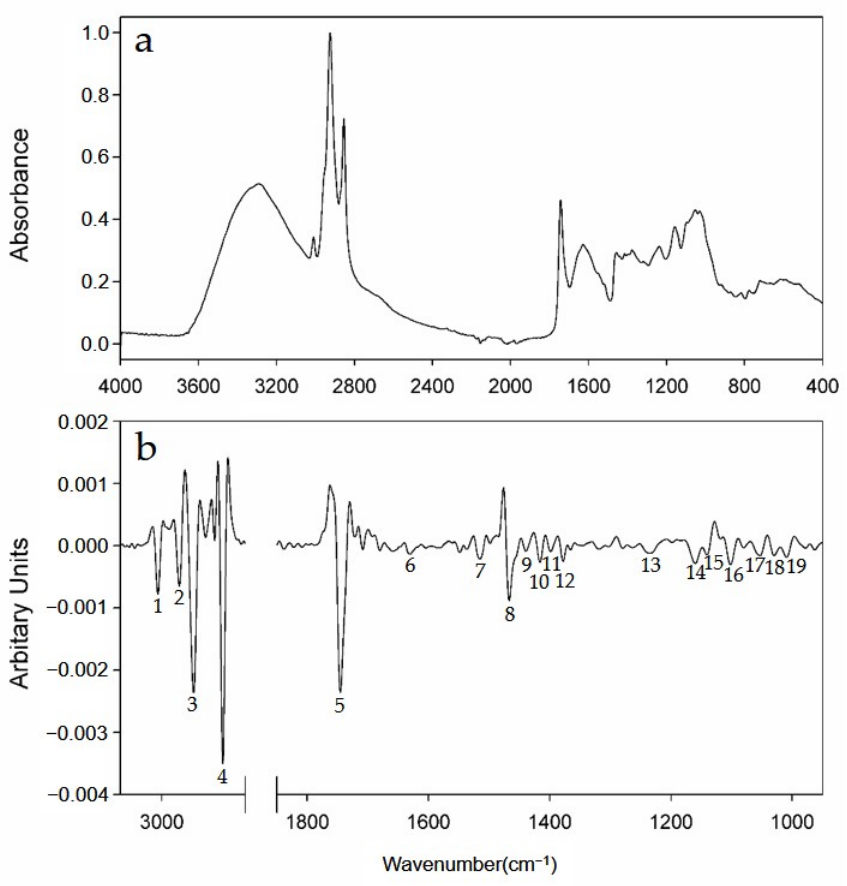
Figure 1. Representative ( a ) FT-IR absorption spectrum of a Korean red pepper powder sample, and ( b ) its second-derivative spectrum (partially expanded at the variables) with numbered peaks (corresponding to the variables in Table 1).